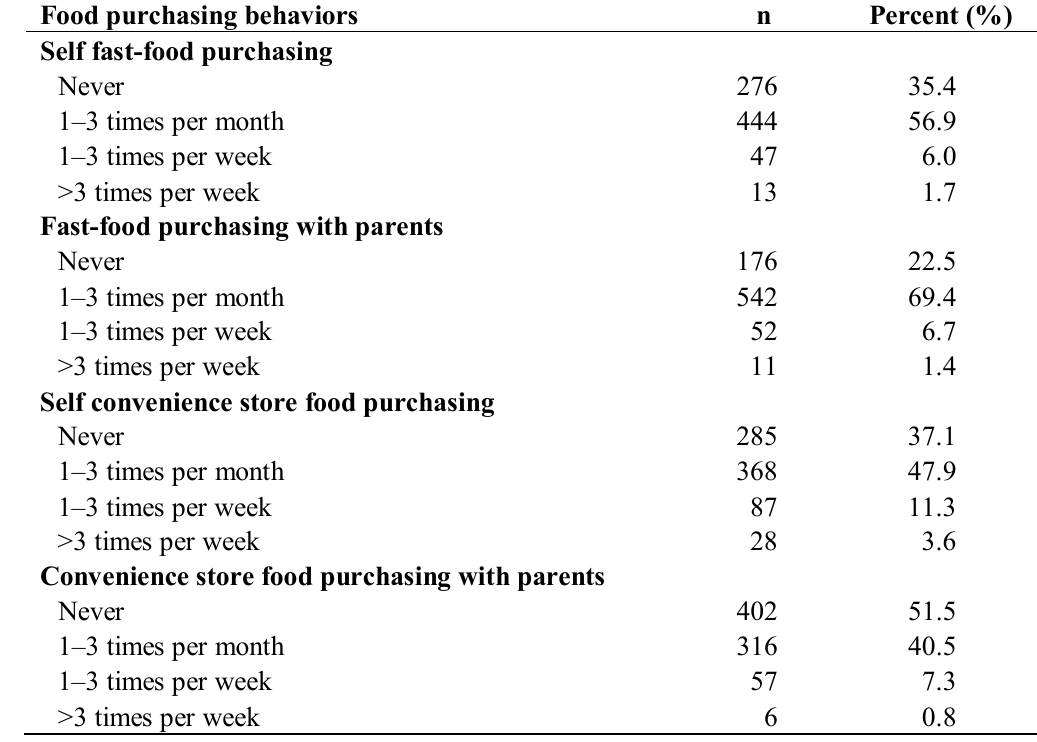
Table 2. Food purchasing behaviors of study subjects (n = 782) *.